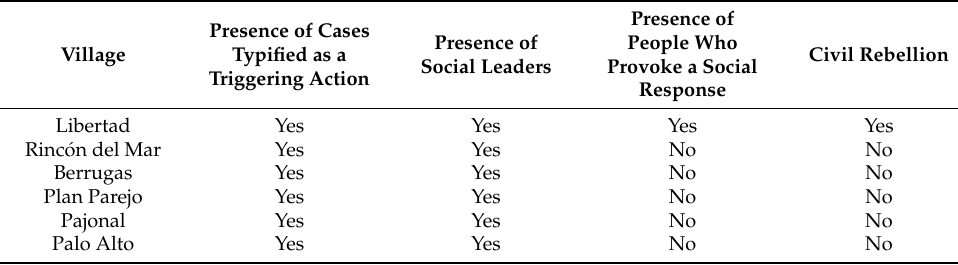
Table 5. Analysis of the presence of agents provocateurs of the social responsibility in the different villages of the municipality of San